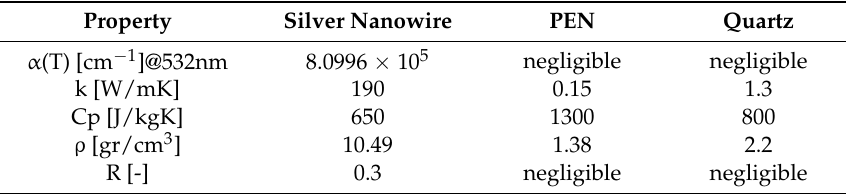
Table 3. Involved Materials’ Properties.